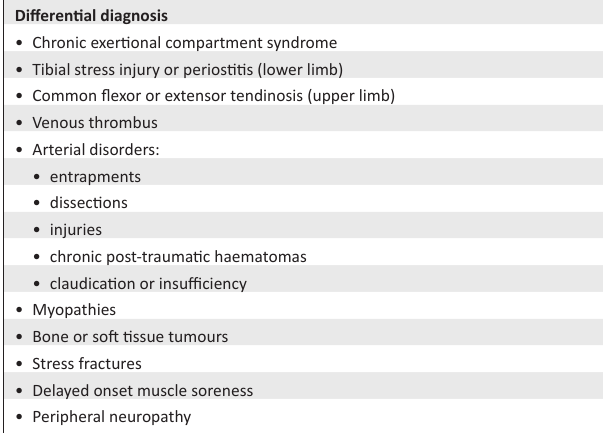
BOX 1: The differential diagnosis for limb